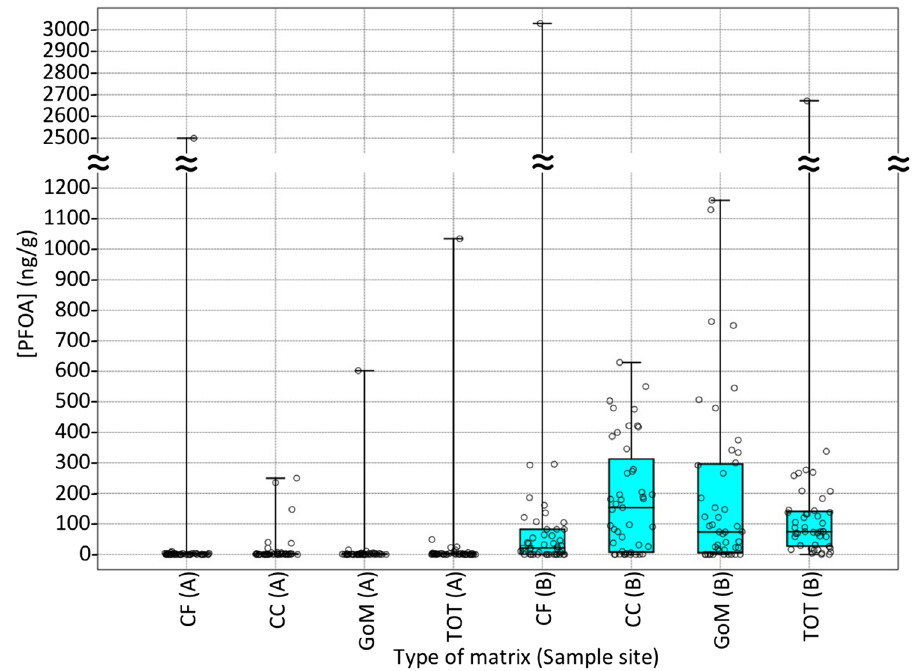
Figure 2. Box and jitter plot showing the concentrations of PFOA found in the Coelomic Fluid (CF) Coelomocytes (CC) and Gonads or Mixed organs (GoM), as well as the total PFOA concentration (TOT), in 45 specimens of P. lividus collected from Site A (left side) and in 45 specimens of P. lividus collected from Site B (right